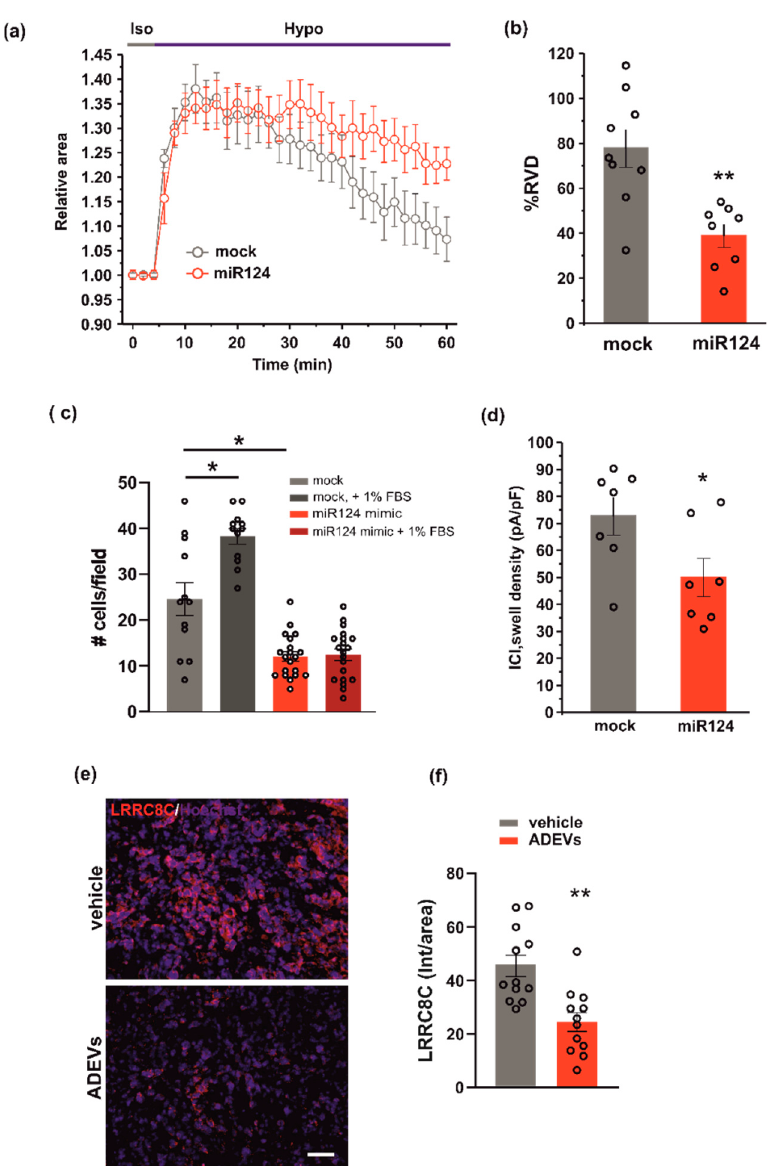
Figure 5. miR124 involvement in ADEVs-mediated effects on GL261 cells. ( a ) Time course of RVD as evaluated from the changes of the relative cell area in vehicle-treated cells (Iso, grey bar) and during the application of a 30% hypotonic solution (Hypo, blue bar) in control mock GL261 cells (mock, grey circles, n = 9) and in miR124-transfected (miR124, n = 12, red circles) GL261 cells. ( b ) Bar plot showing the average percentage of RVD in mock- and miR124-transfected GL261 cells, calculated as follows: %RVD = (Arel,peak − Arel,56 min)/(Arel,peak)) × 100. Data mean ± SE; Student’s t -test ** p < 0.01. ( c ) GL261 mock- or miR124-transfected GL261 cells were assayed for basal- or FBS-induced invasion on Matrigel. GL261 invasion was measured as a mean number of invading cells/field ± SE, N = 3, at least 4 fields per condition; Student’s t -test, * p < 0.05. ( d ) Bar plot showing the average current density measured at − 80 mV during the exposure to a 30% hypotonic solution, in mock- ( n = 13) and miR124-transfected ( n = 12) GL261 cells. Data mean ± SE; Student’s t -test * p < 0.05. ( e ) Representative immunofluorescence analysis for LRRC8C (in red; Hoechst in blue) of coronal brain sections of GL261-bearing mice treated with a vehicle and with ADEVs, scale bar 50 µ m. ( f ) Data are expressed as a mean intensity (Int) per area ± SE; N = 3, 4 fields per condition; Student’s t -test, * p <